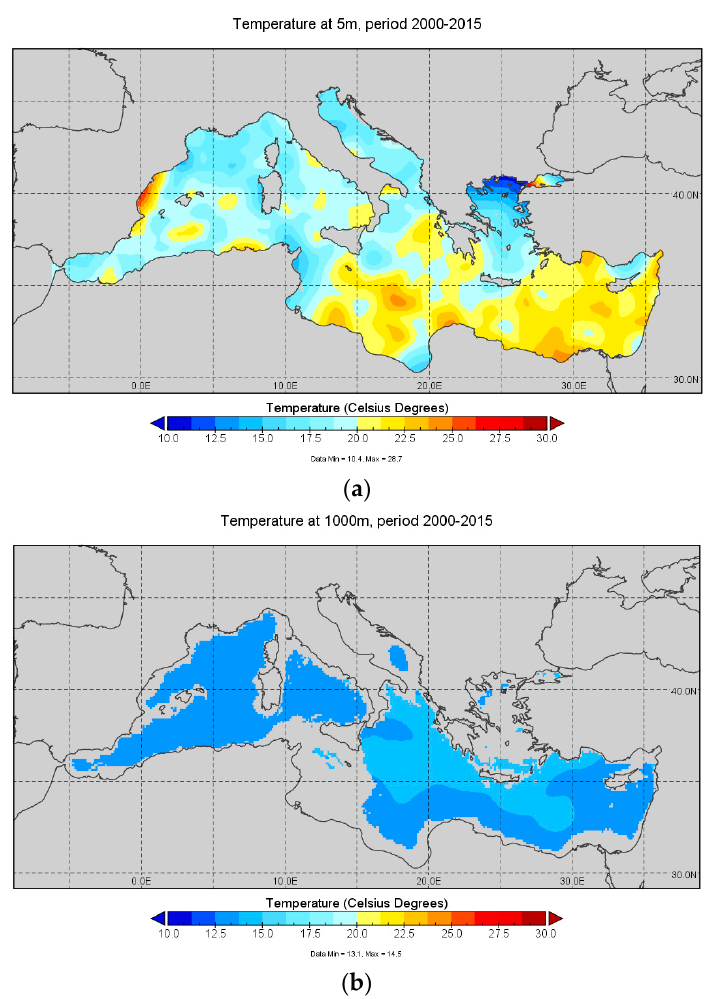
Figure 9. ( a ) Mean annual sea temperature at 5 m below sea level in the Mediterranean Sea; ( b ) Mean annual sea temperature at 1000 m below sea level in the Mediterranean Sea. Data obtained from SeaDataNet and analyzed by HCMR.